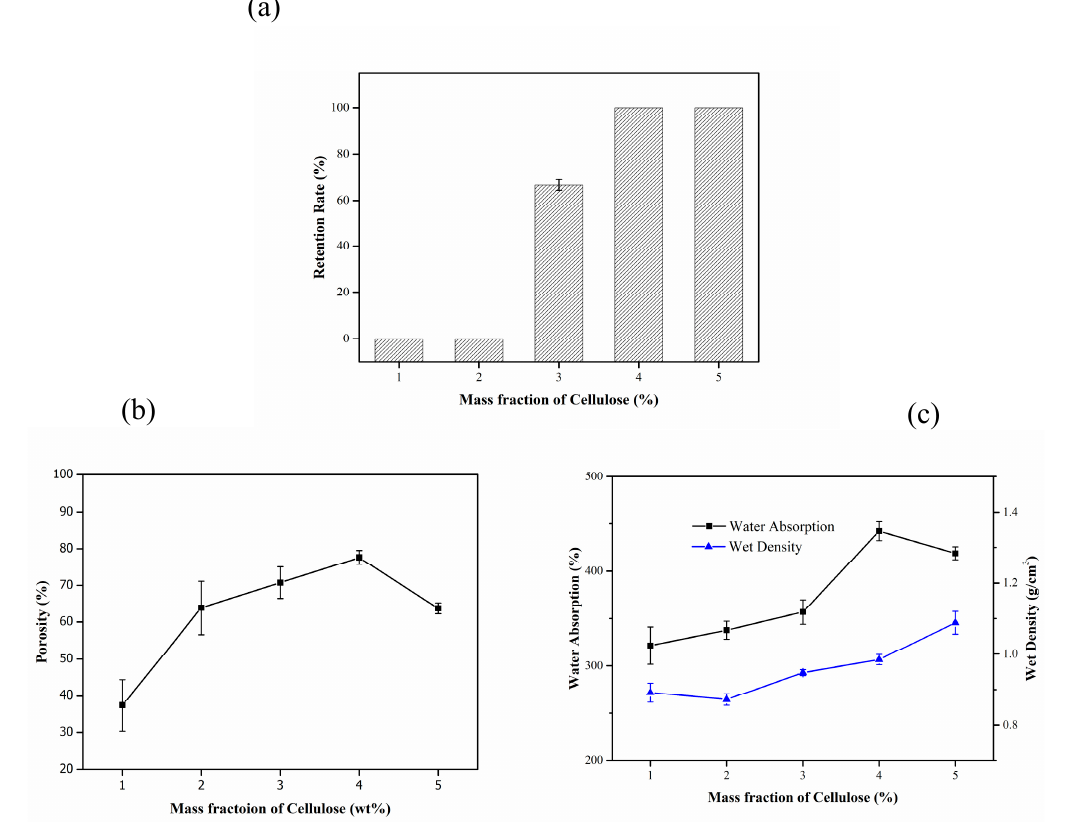
Figure 2. E ff ect of the mass fraction of cellulose on the properties of the composite carrier. ( a ) E ff ect of the mass fraction of cellulose on retention rate; ( b ) E ff ect of the mass fraction of cellulose on porosity; ( c ) E ff ect of the mass fraction of cellulose on water absorption and wet